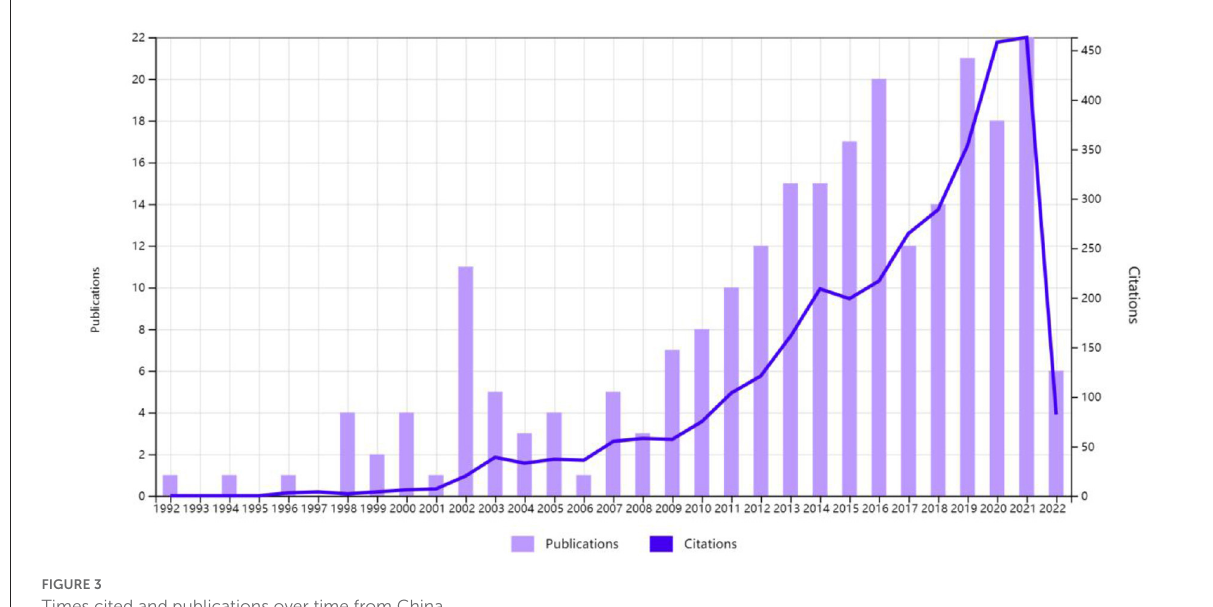
FIGURE3 Times cited and publications over time from China.